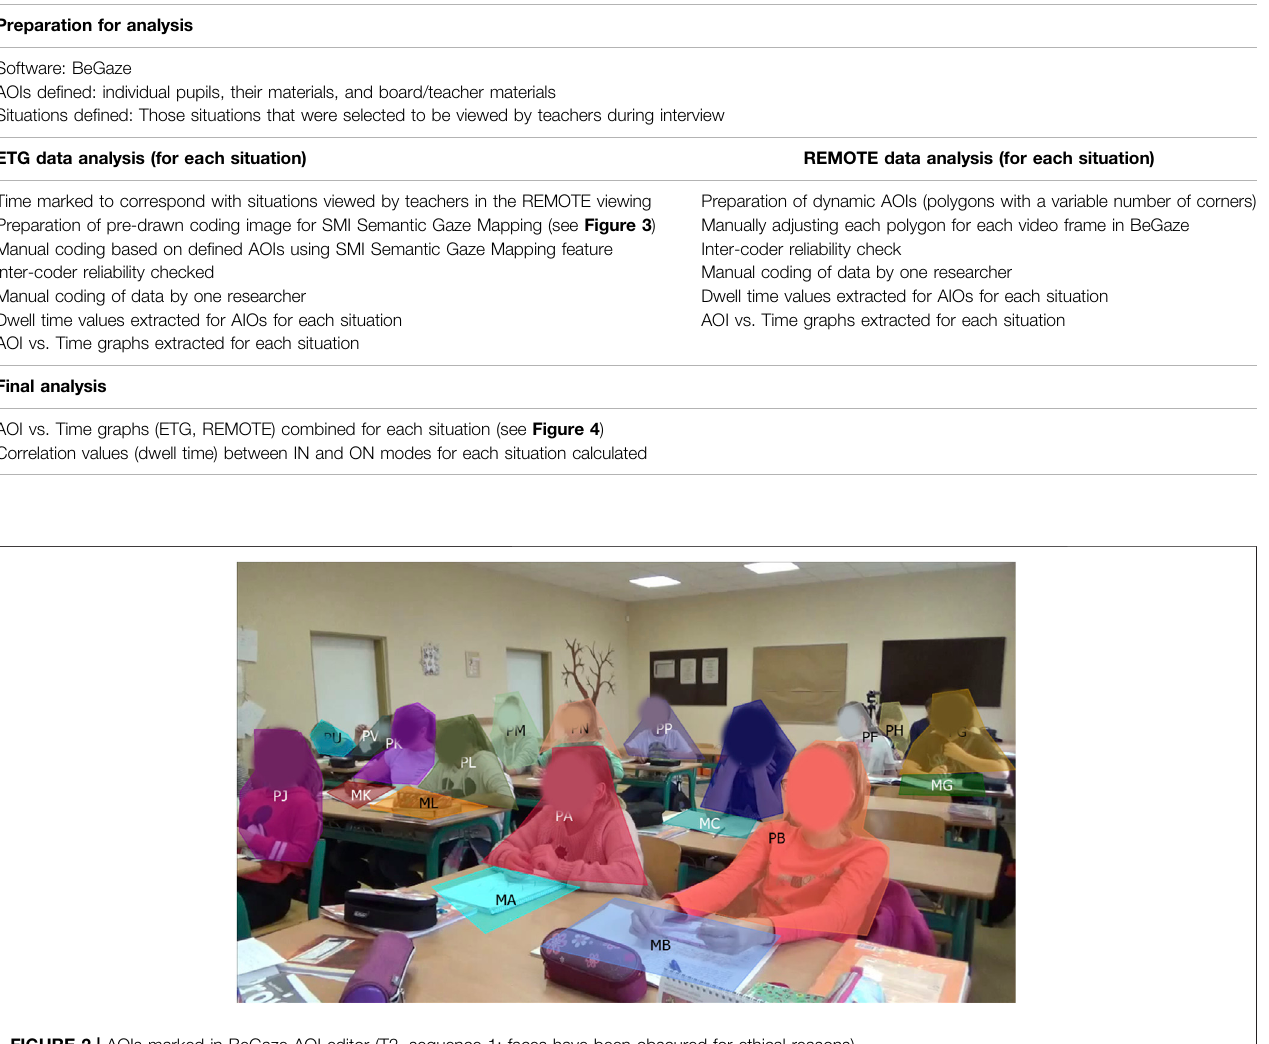
TABLE 3 | Analysis of eye-tracking data.